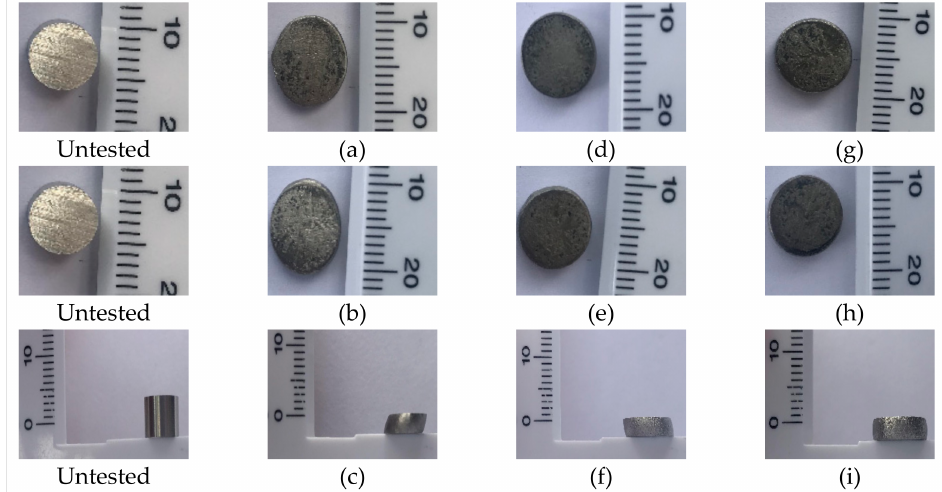
Figure 8. Geometry of untested and tested samples (where a – c equals samples built with a 0 ◦ hatch angle in the x-, y-, and z-direction, respectively, d – f equals samples built with a 67 ◦ hatch angle in the x-, y-, and z-direction, respectively, and g – i equals samples built with a 105 ◦ hatch angle in the x-, y-, and z-direction, respectively).